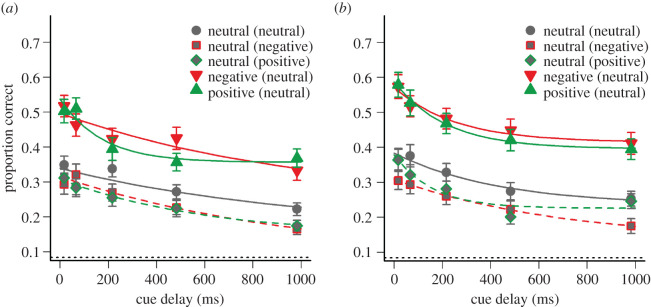
Mean visual recognition accuracy of neutral, positive, and negative targets as a function of the cue delay in the first (a) and second (b) block of experiment 2. Positive and negative targets were to be selected against neutral distractor, and neutral targets were to be selected against neutral, positive, or negative distractors (distractor valence indicated in the parentheses of the legend). Error bars depict standard errors of the mean. Solid and dashed lines represent exponential decay functions fitted to recall accuracy. The dotted line at the bottom represents the chance level for target recognition.